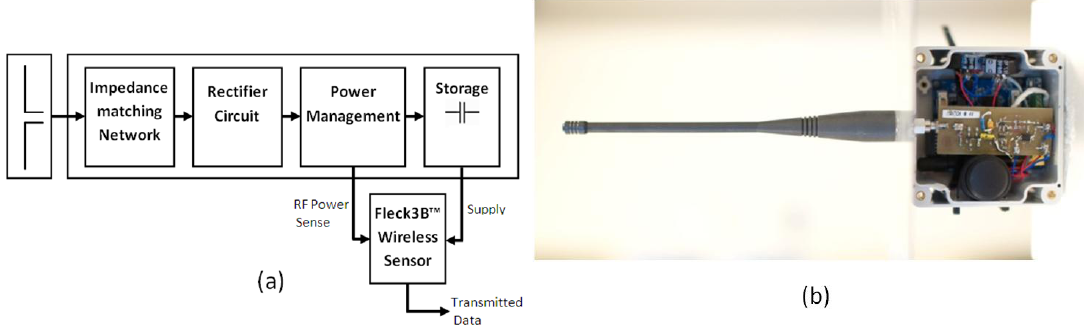
Figure 2. The leaf node: ( a ) harvesting circuit block diagram and ( b ) showing the power receiving antenna, harvesting circuit and Fleck TM 3B